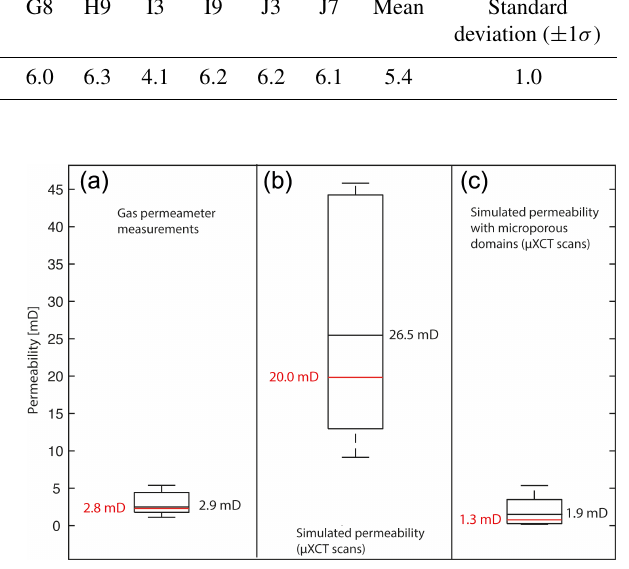
Figure 11. Comparison of measured and simulated permeabilities. The boxes indicate the upper and lower quartile of derived perme- ability values. Median values are coloured in red; mean values are coloured in black. (a) Measured permeabilities using the gas per- meameter test. (b) Simulated permeabilities using µXCT data. (c) Simulated permeabilities using µXCT data with modelled microp- orous